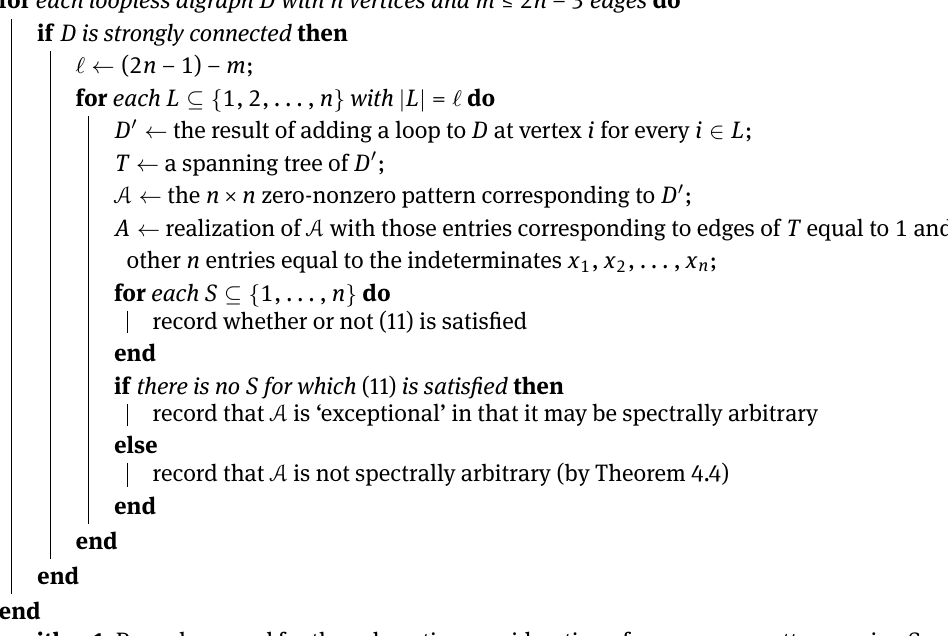
Algorithm 1: Procedure used for the exhaustive consideration of sparse n × n patterns using SageMath (see the Appendix for the source